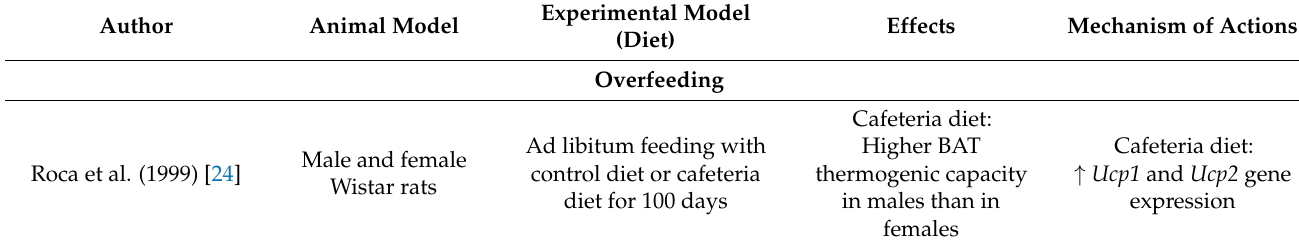
Table 2. Sexual dimorphism in thermogenesis induced by diet in preclinical